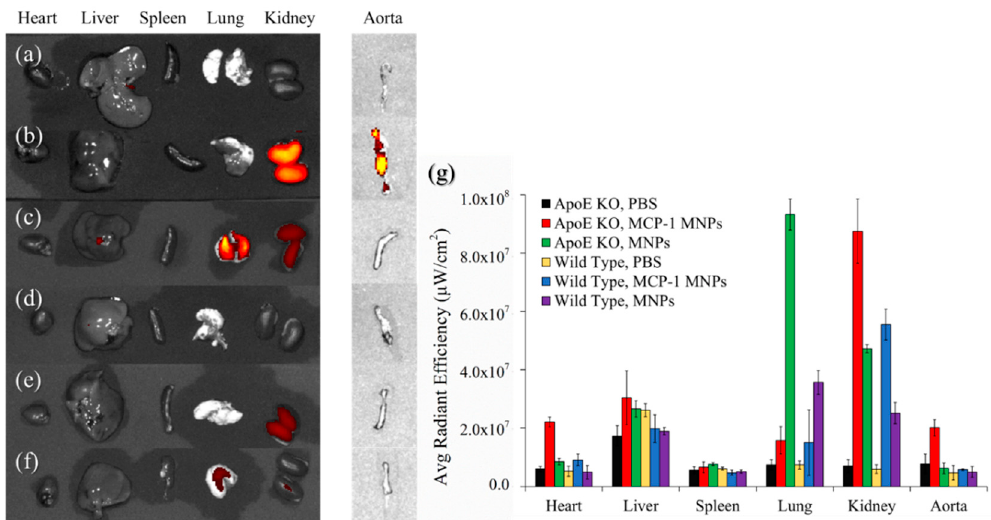
Figure 9. IVIS organ fluorescence of ApoE KO mice injected with ( a ) PBS; ( b ) MCP-1-motif MNPs; ( c ) MNPs, and wild-type mice injected with ( d ) PBS; ( e ) MCP-1-motif MNPs; ( f ) MNPs. ( g ) Average radiant efficiency diagram of IVIS organ fluorescence ( n = 3).